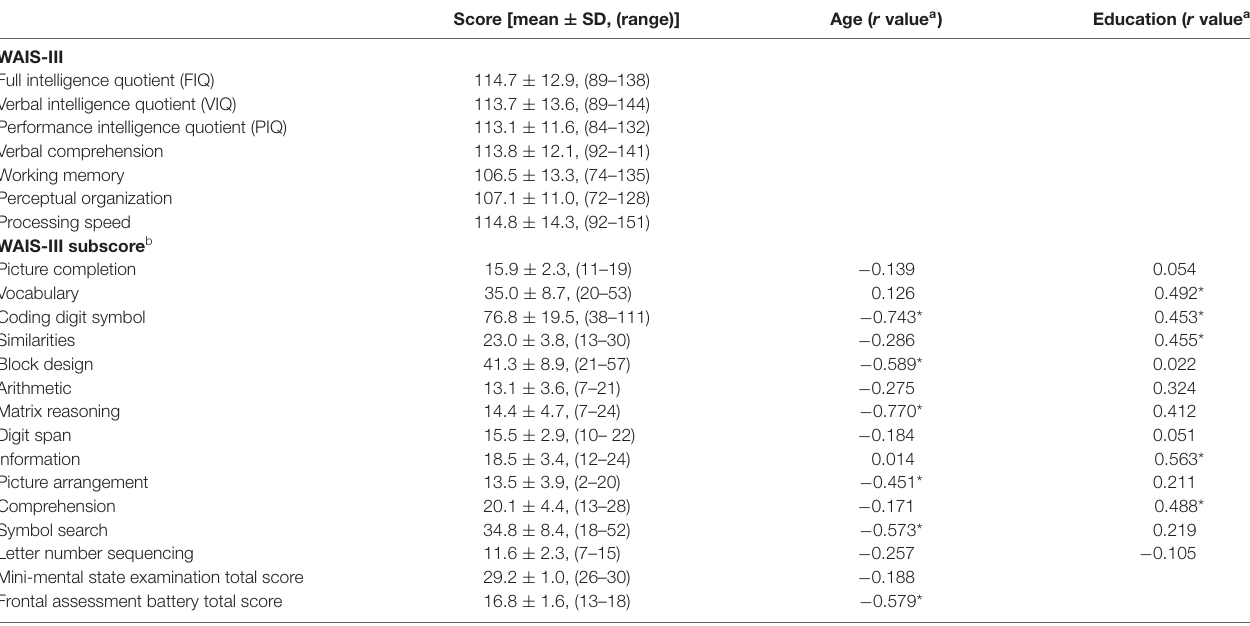
TABLE 1 | Summary of the neuropsychological tests and correlation with age and education in 30 normal subjects. Score [mean ± SD, (range)] Age ( r value a ) Education ( r value a ) WAIS-III Full intelligence quotient